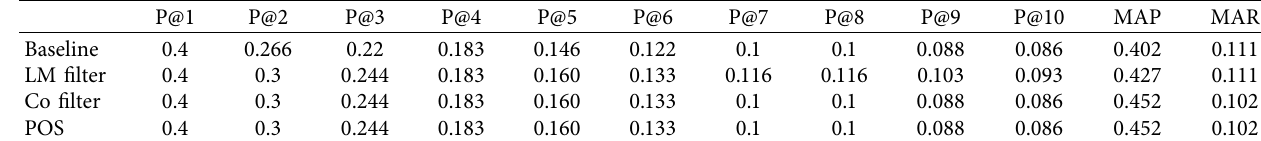
Table 13: Automatic evaluation results after using the SynoExtractor pipeline on KSUCCA